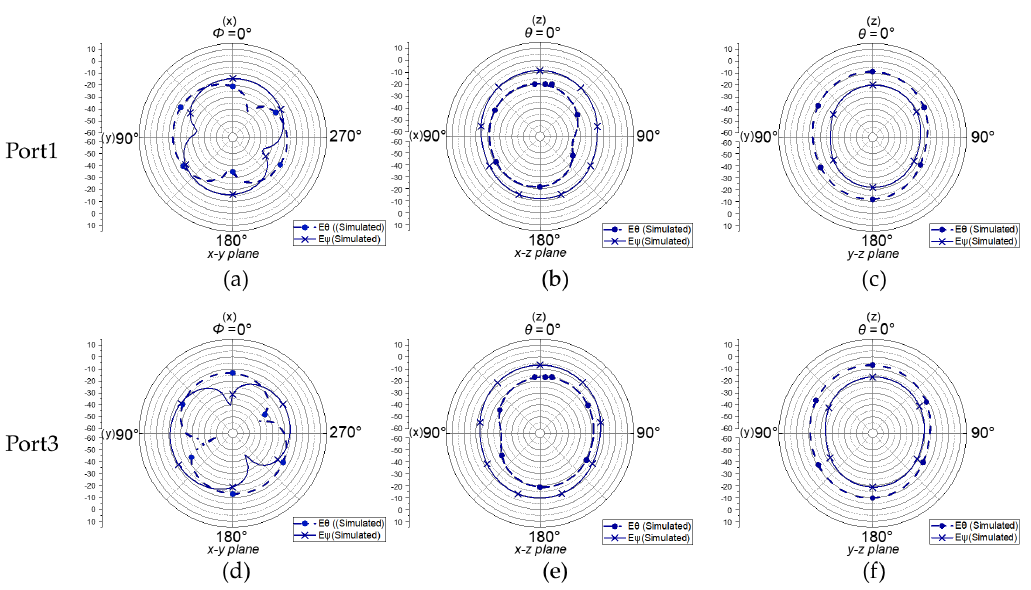
Figure 11. The x - y , x - z , and y - z planar field patterns without the metal ring are ( a – c ) for port 1 feed and ( d – f ) for port 3 feed.